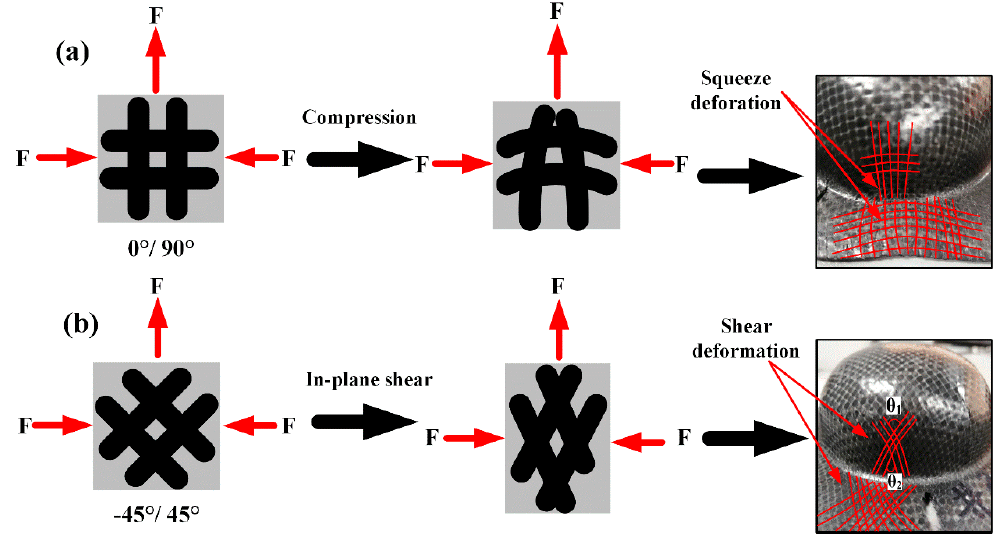
Figure 16. Schematic diagram of the deformation of woven unit in different fiber directions: ( a ) the [0°/90°] position, ( b ) the [ − 45°/45°] position.